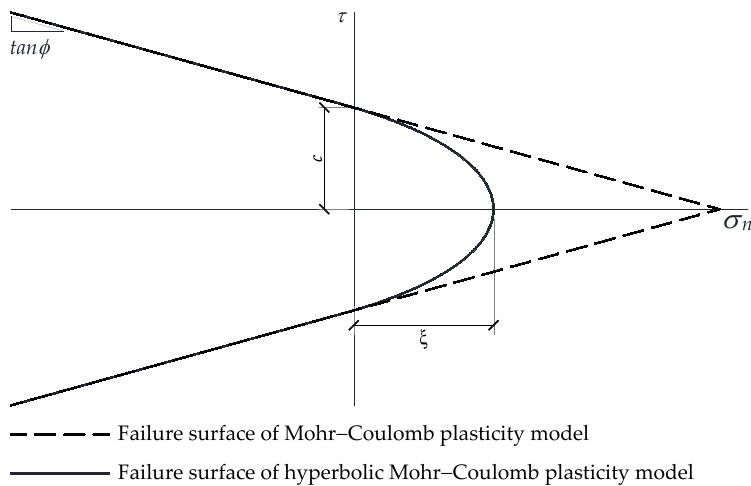
Figure 4. Failure surface of hyperbolic Mohr–Coulomb plasticity model illustration.